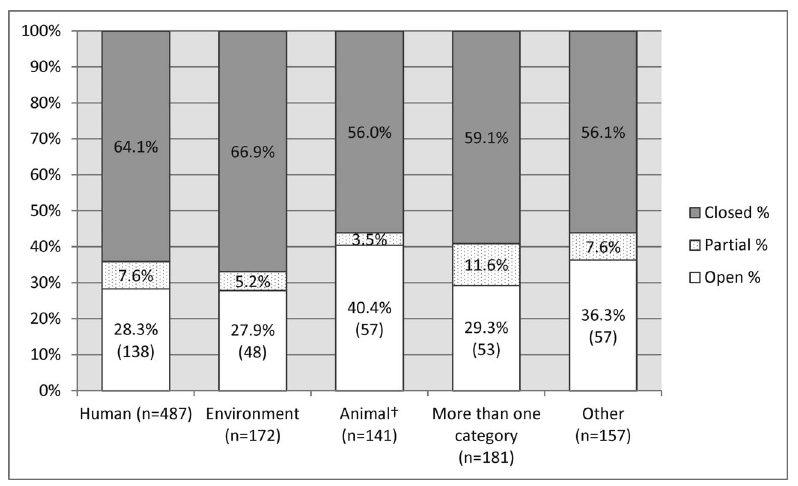
Figure 2 Journal-level open access (OA)* by subject category (n ¼